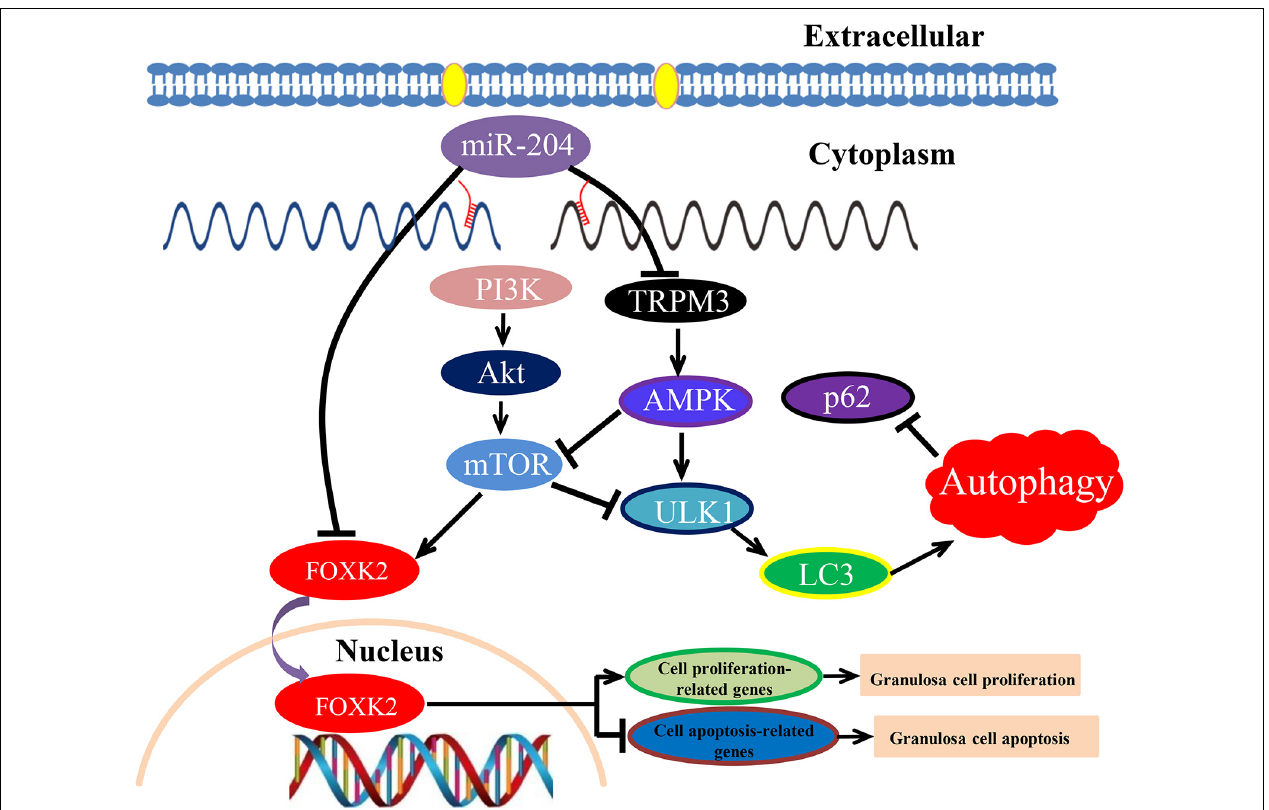
FIGURE 10 | Schematic model of miR-204-mediated regulatory mechanism in chicken granulosa cell (GC) proliferation, apoptosis, and autophagy. miR-204 promotes GC apoptosis by repressing Forkhead box K2 (FOXK2) via the phosphoinositide 3-kinase (PI3K)/AKT/mammalian target of rapamycin (mTOR) regulation pathway and inhibits autophagy by impeding the transient receptor potential melastatin 3 (TRPM3)/AMP-activated protein kinase (AMPK)/ULK